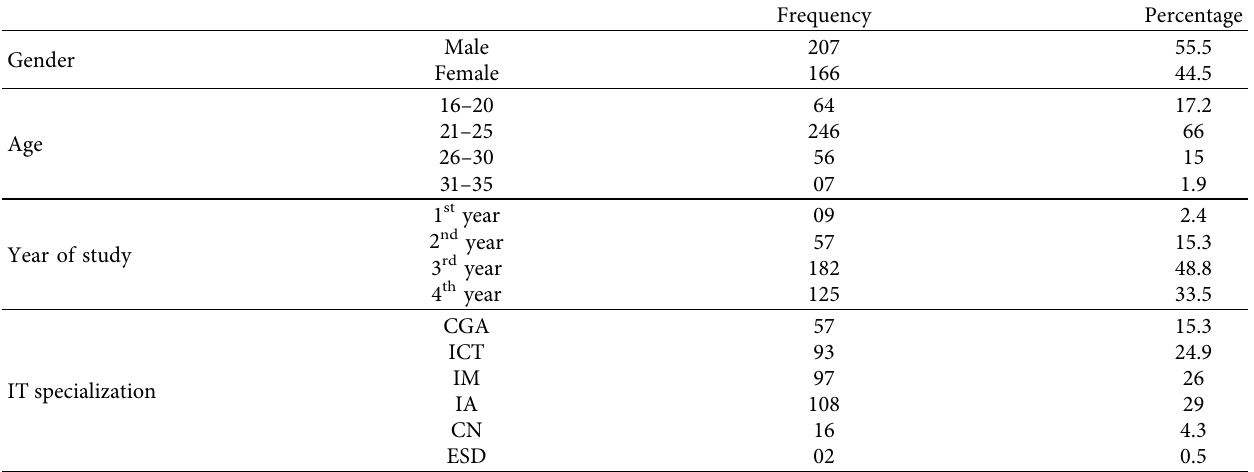
Table 2: Demographic of respondents.